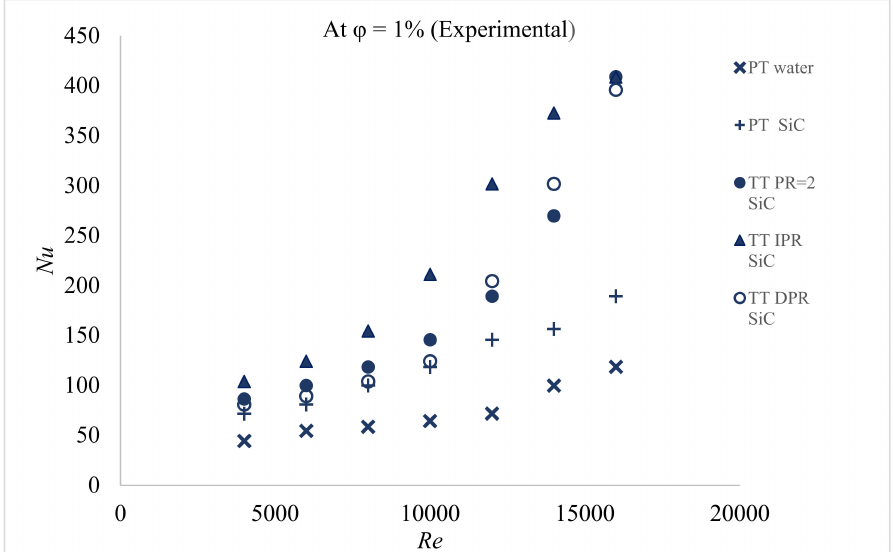
Figure 16. E ff ect of the type of inserts on Nu (Numerical).